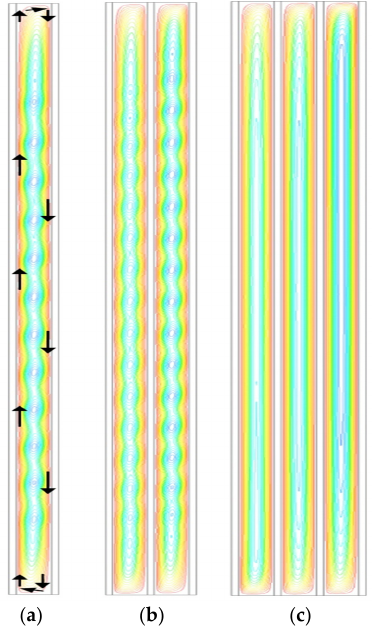
Figure 6. Streamlines in ( a ) double-, ( b ) triple-, and ( c ) quadruple-pane windows for L = 21 mm and Δ T = 15 °C [7].